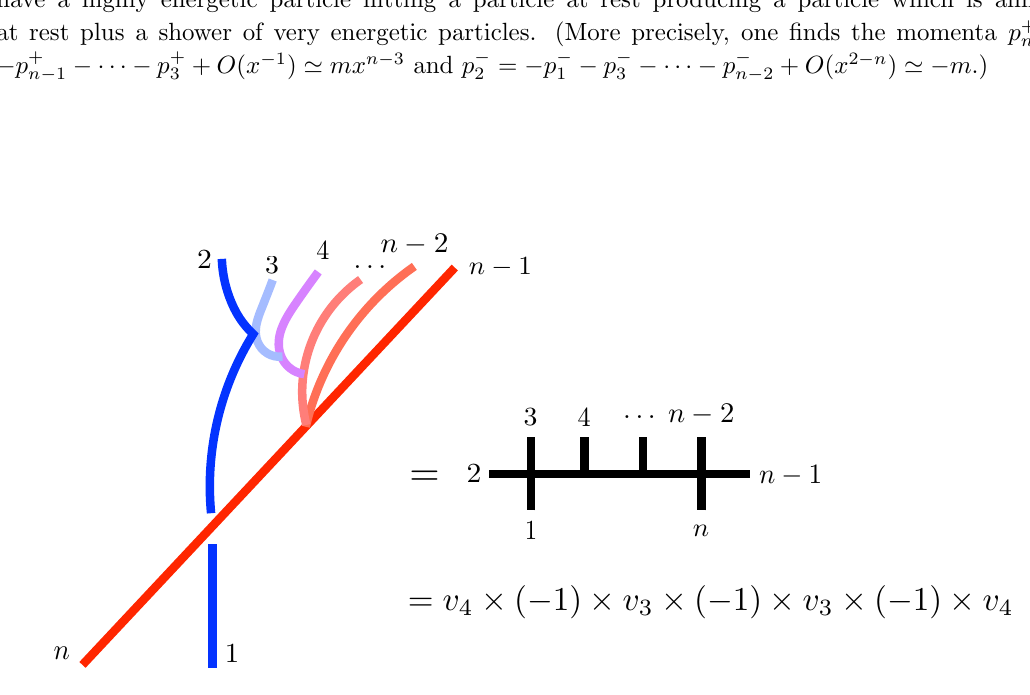
Figure 2 . The only surviving diagrams in the multi-Regge limit are one-dimensional chains with particles ordered along the chain. They evaluate to the product of involved vertices and ( propagator.